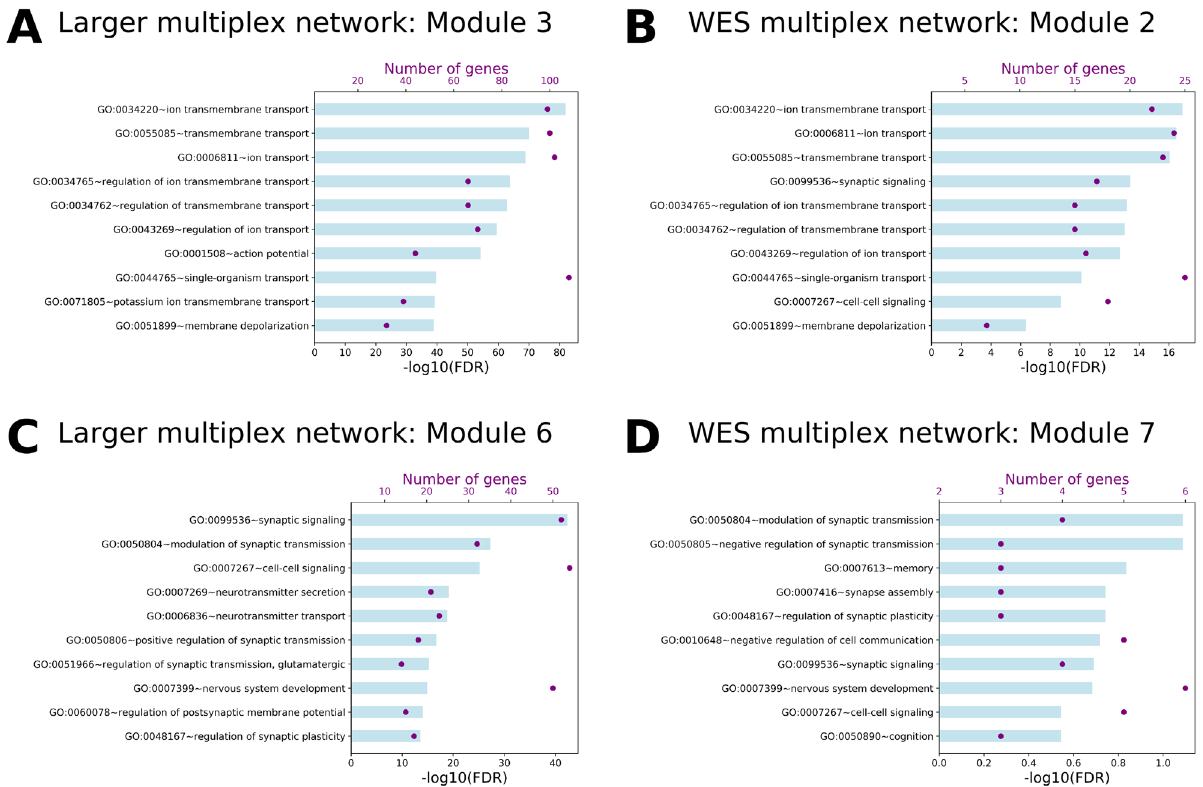
( A ) Module 3 and ( B ) Module 6 of the larger multiplex network and their corresponding modules ( C ) Module 2 and ( D ) Module 7 of the WES multiplex